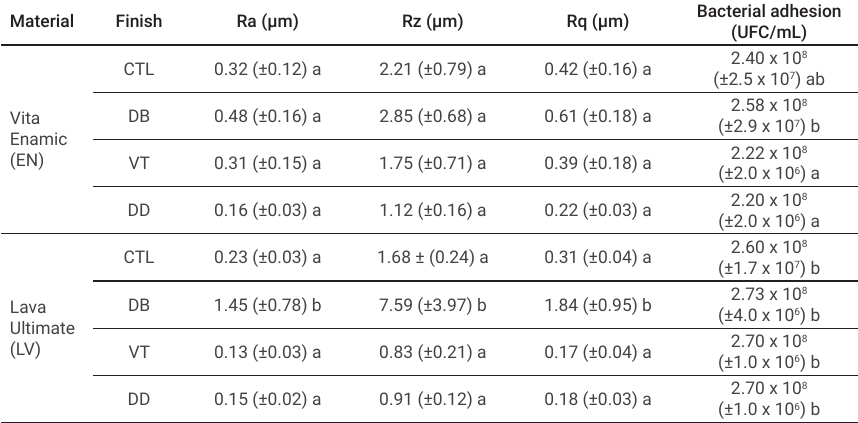
Table 1. Mean and standard deviation of roughness (µm) and bacterial adhesion (CFU/mL) for the different groups (n=8).